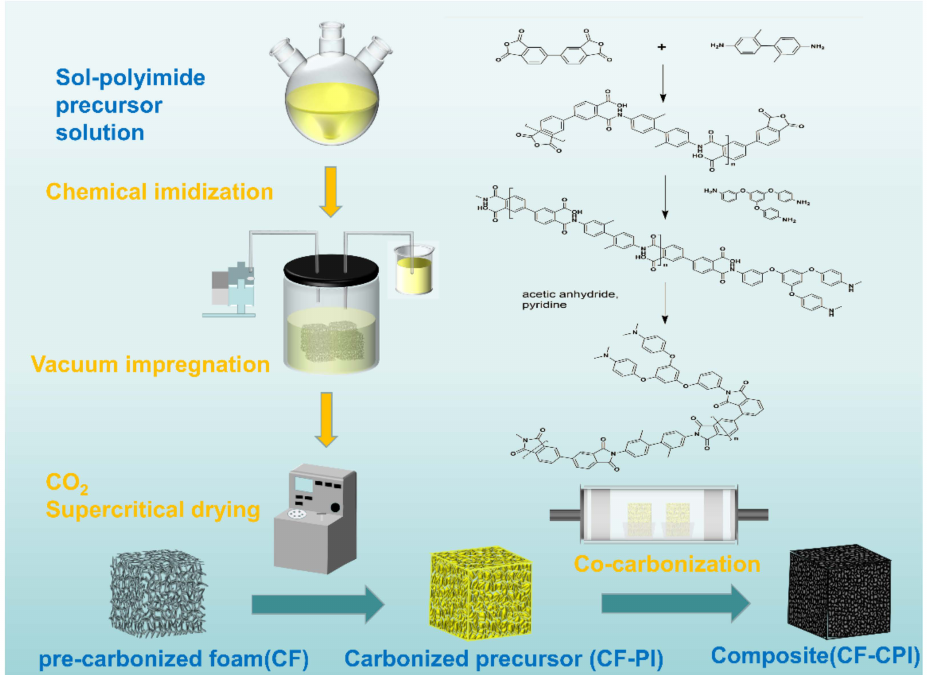
Figure 1. Preparation diagram of polyimide-based carbon aerogel-reinforced carbon foam